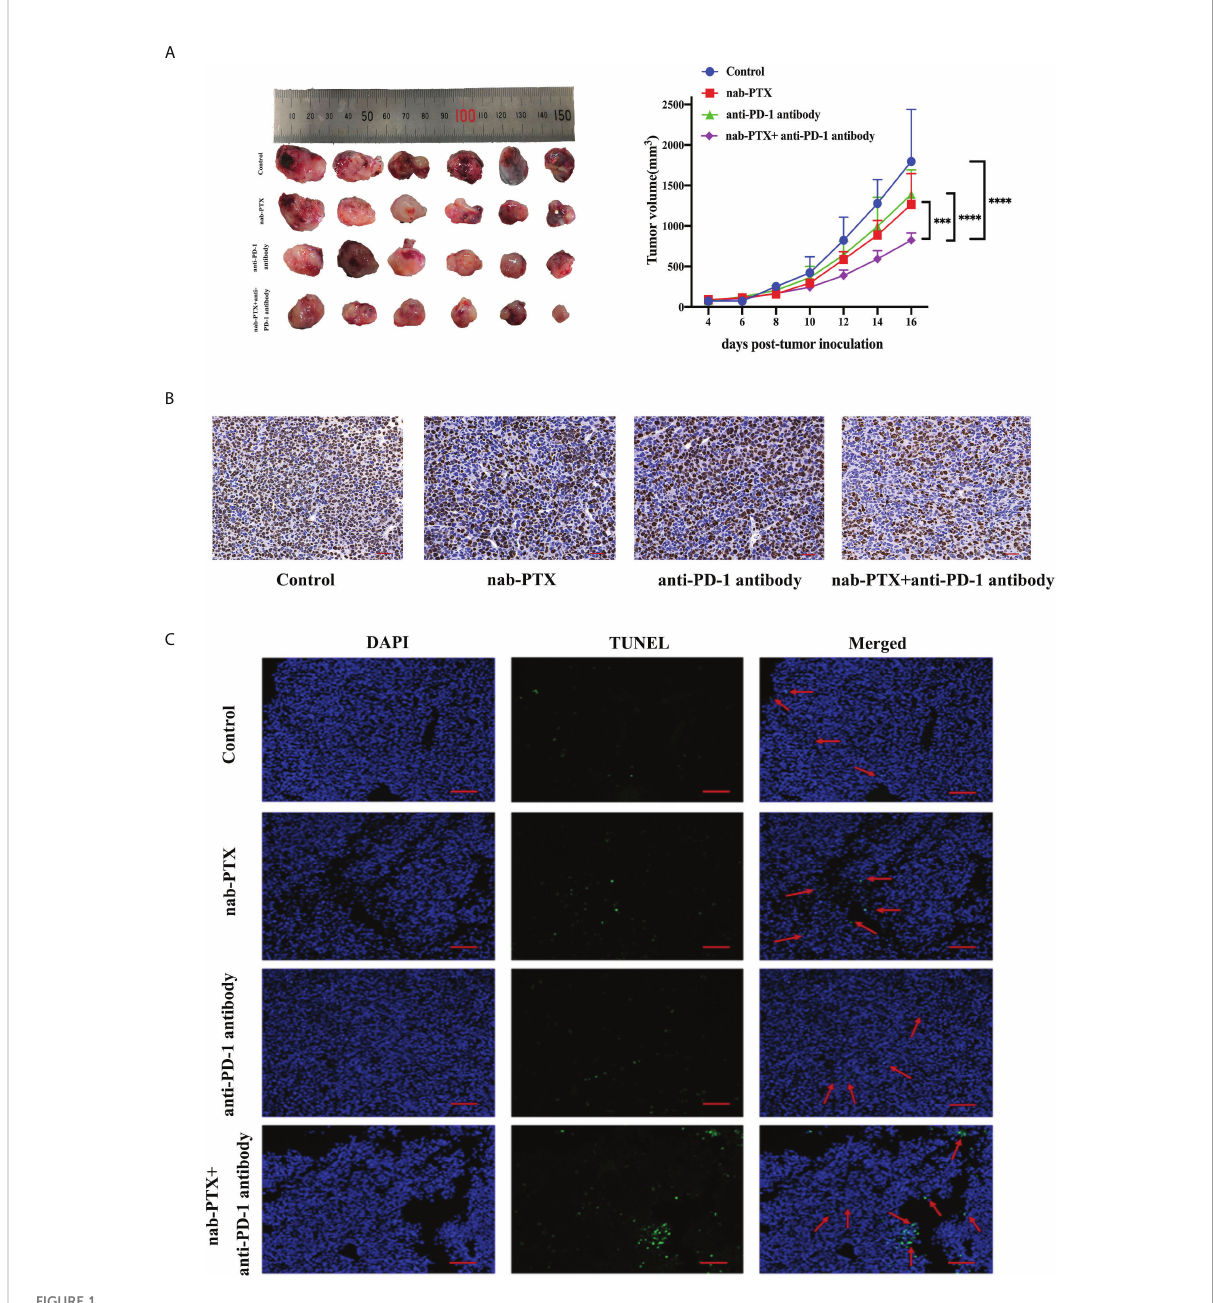
FIGURE 1 The antitumor responses of mice treated with nab-paclitaxel (nab-PTX) and anti-PD-1 antibody. (A) Macroscopic images and tumor growth curve in mouse LLC cancer models ( n = 6, biological duplicates), statistically analyzed with two-way ANOVA followed by Tukey ’ s multiple comparisons. *** p < 0.001, **** p < 0.0001. (B) Immunohistochemistry staining of Ki67 for tumor sections ( n = 3, magni fi cation ×20, biological duplicates). The hematoxylin-stained nucleus is blue, and the positive expression of DAB is brownish yellow. (C) Apoptosis detection of tumor sections by TUNEL staining after the last administration ( n = 3, magni fi cation ×200, biological duplicates). Green, TUNEL staining; blue, DAPI. The red arrow denotes a representative TUNEL-positive